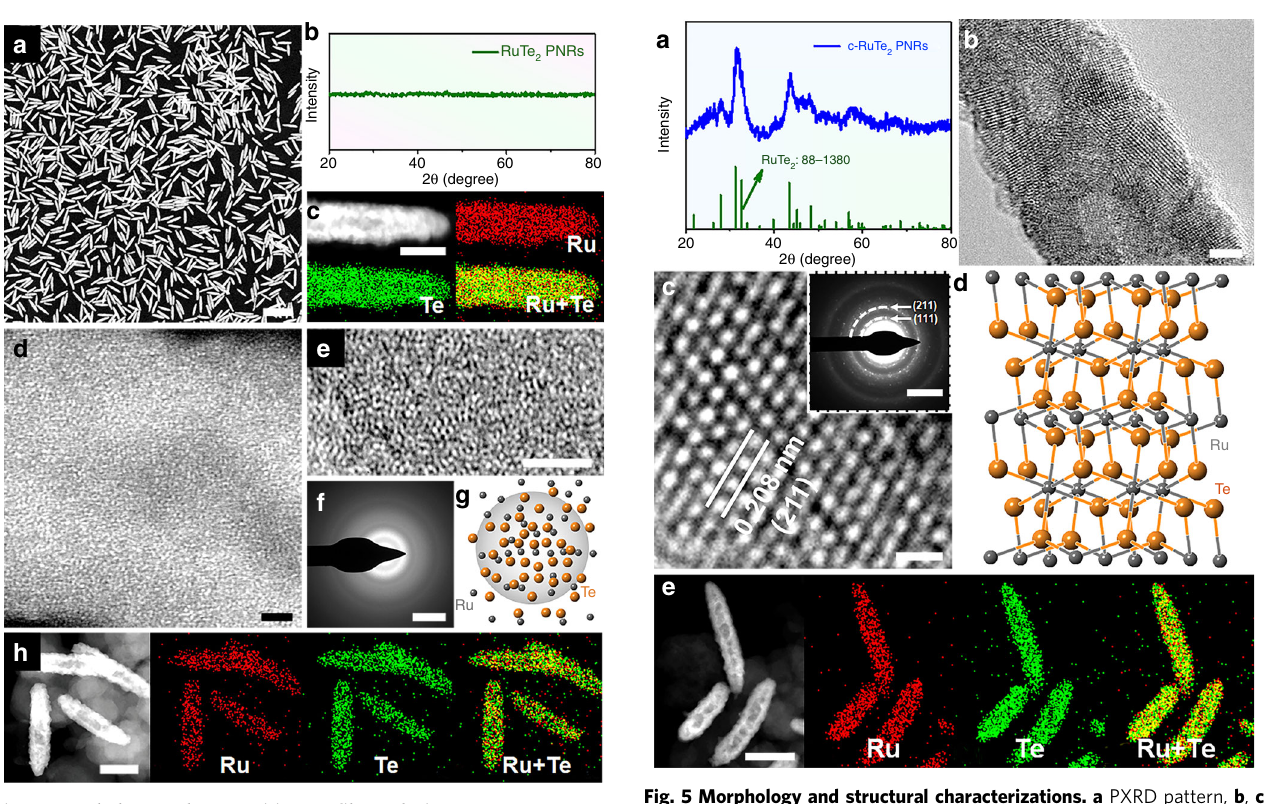
Fig. 4 Morphology and composition pro fi le analysis. a HAADF-STEM image, b XRD pattern, c STEM-ADF image and EDS elemental mappings of RuTe 2 PNRs. d Atomic-resolution HAADF-STEM image, e HRTEM image, f SAED pattern, g structural model, and h STEM-ADF image and EDS elemental mappings of carbon supported a-RuTe 2 PNRs. Scale bar, a 200 nm; c 10 nm; d , e 2 nm; f 5 1/nm, and h 40 nm.